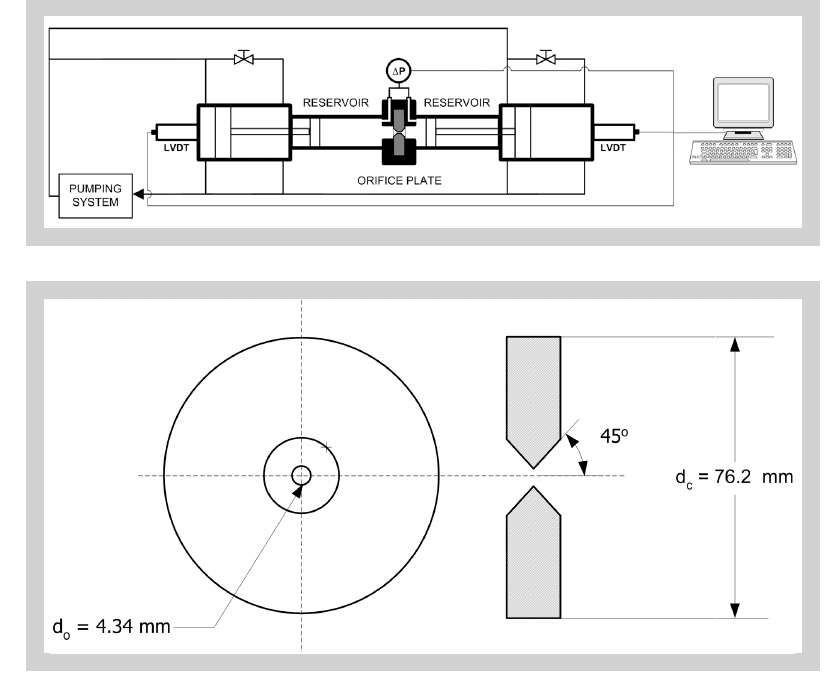
Figure 2 (left): Schematic diagram of the orifice flowmeter. Figure 3 (right): Orifice